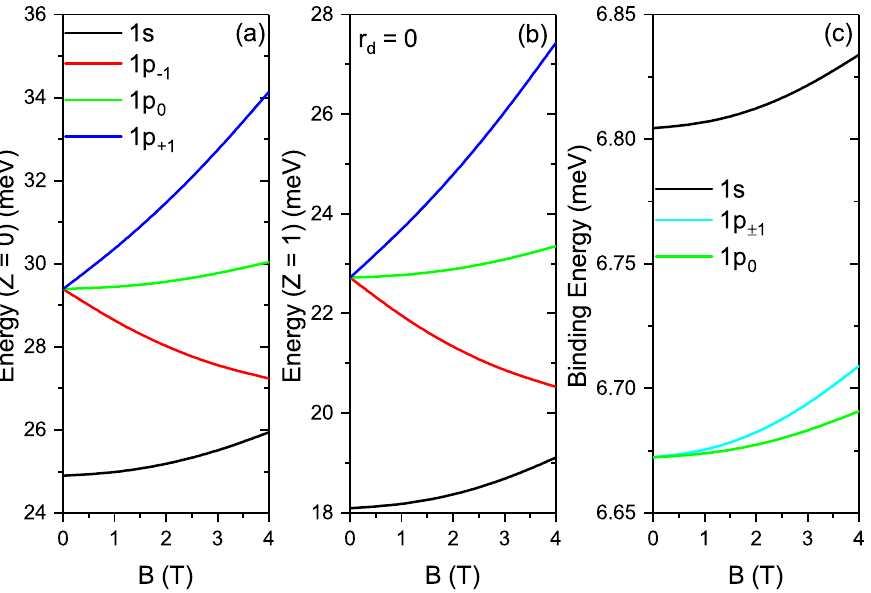
Figure 2. ( a ) Electron energies versus the MF in the absence of impurity; ( b ) Electron energies versus the magnetic field in the presence of DI. ( c ) Binding energies versus the